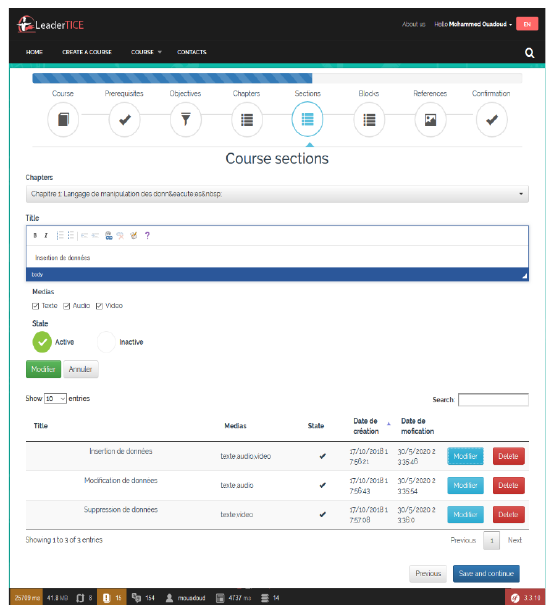
Fig. 7. Course sections interface developed by the NoSQL MongoDB database and the Symfony